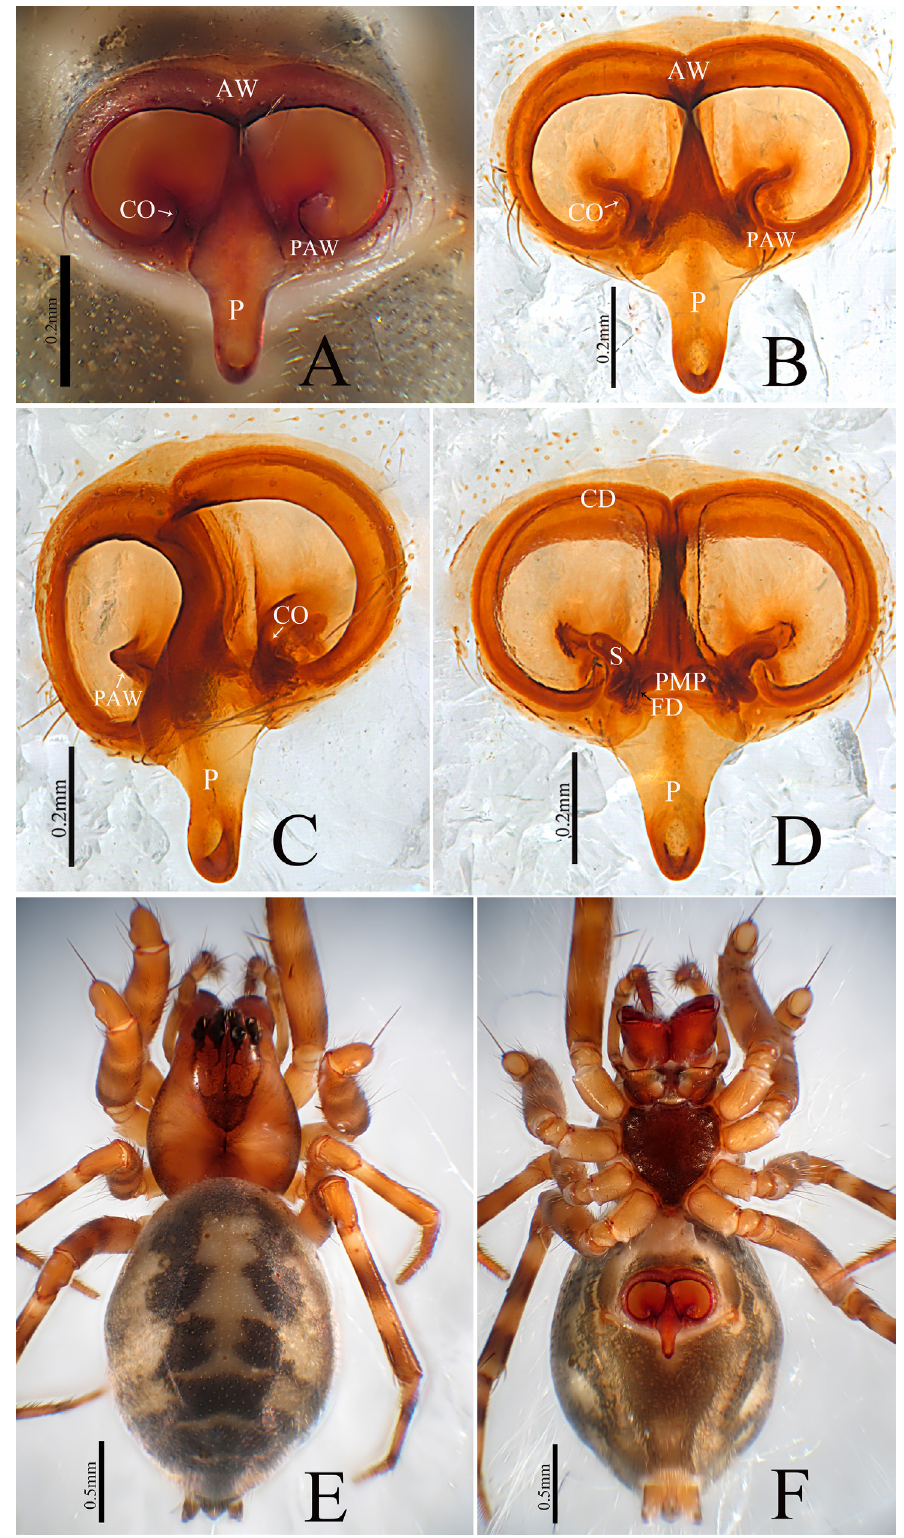
Fig. 29. Acroterius longidentatus gen. et sp. nov., ♀, holotype (HNU-2002–033A). A–B . Epigyne, ventral view. C . Epigyne, lateral view. D . Vulva, dorsal view. E . Habitus, dorsal view. F . Habitus, ventral